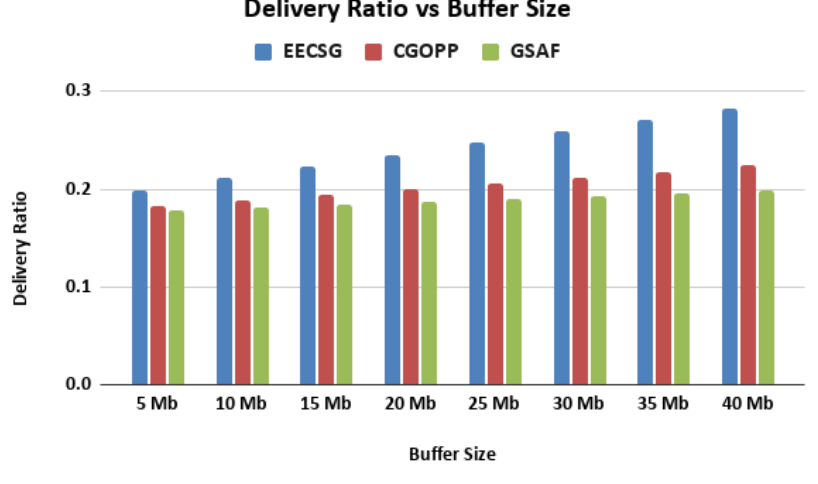
Figure 11. Delivery ratio vs. buffer size using real data mobility